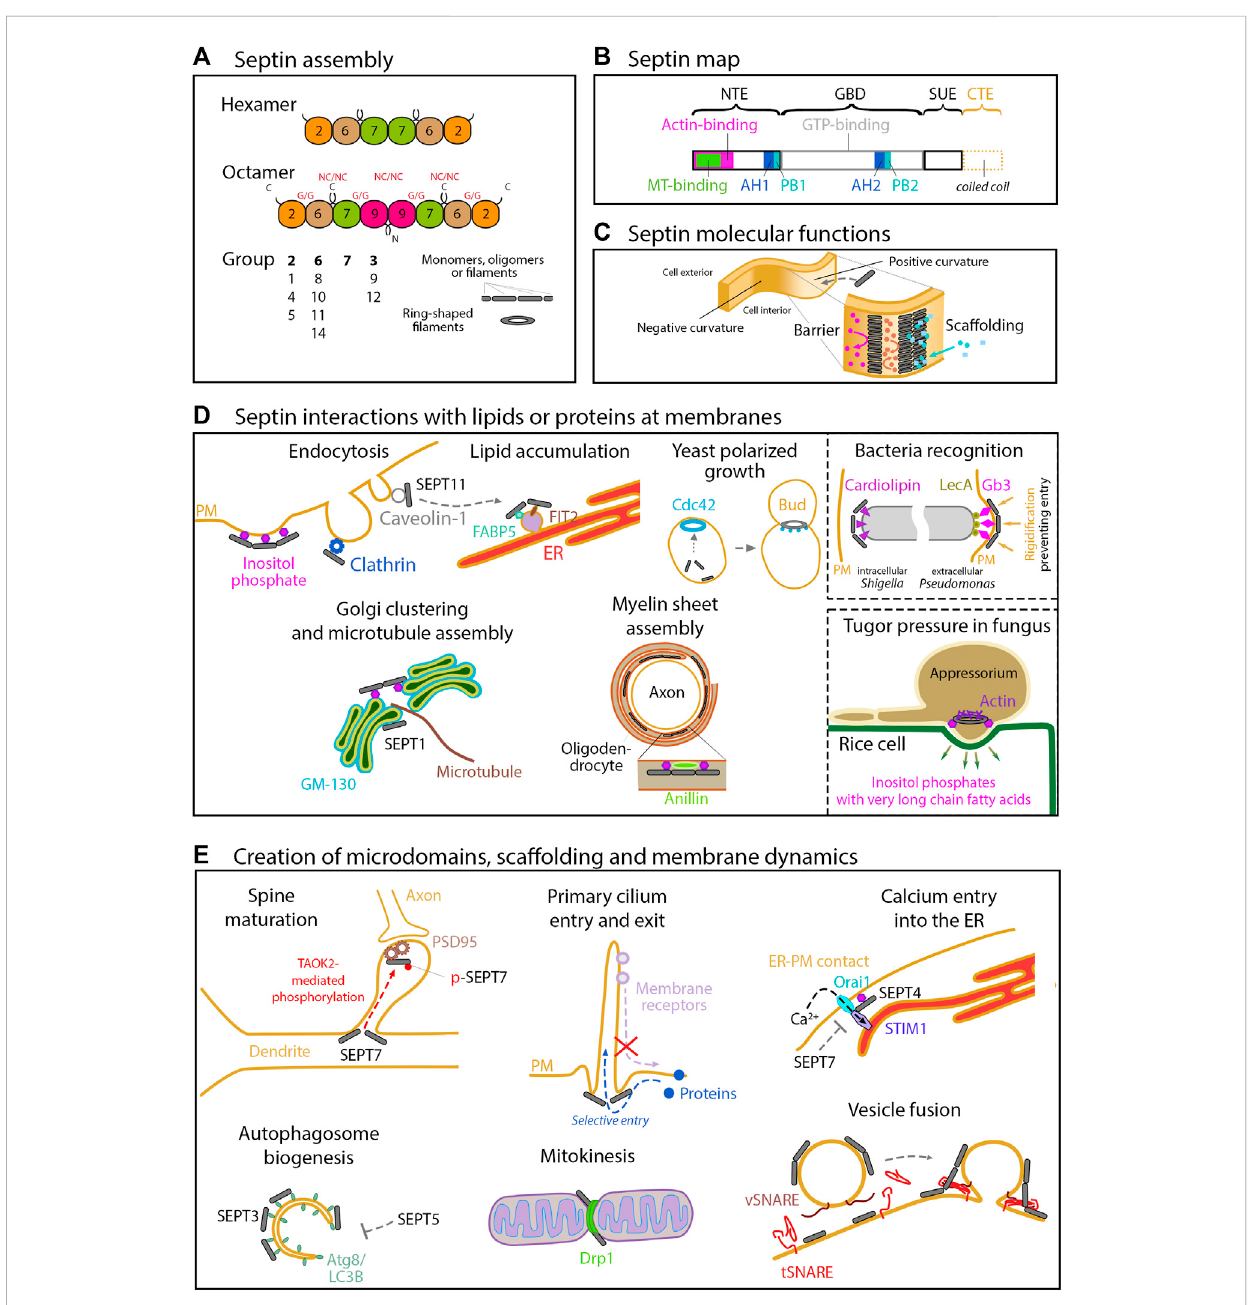
Septin structure, assembly and functions related to membranes. (A) Assembly of the septin cytoskeleton. In humans, the septin family comprises 13 members organized into 4 groups (2, 6, 7 and 3) according to their sequence homology. The organization of the four septin group into hexamers and octamers is depicted. Septin monomers either interact through their N- and C-terminal domains (NC/NC interfaces), or through their GTP-binding domain (G/G interfaces). These oligomers can then assemble into fi laments or into rings. (B) Structural domains encountered in septin proteins. All theseptinsexhibitaGTP-bindingdomain(GBD),aseptinuniqueelement(SUE),andN-andC-terminalextensions(NTE,CTE)ofvariablelength.Notethat the CTE, which contains one or more coiled-coil regions is absent in group 3 septins. Membrane binding is mediated by two AH (amphipathic helix) and PB (polybasic domain) motifs. SEPT9 exhibitsphysicalbinding to F-actin through the fi rst half ofits NTE, and to microtubulesthrough itsN-terminal K/R- R/x-x-D/Erepeatmotifs. (C) Septinmolecularfunctions.Atthemolecularlevel,septinscanformdiffusionbarriersoractasscaffolds,asillustratedherein thecontext ofbindingto apositivelycurved membrane.As abarrier,septins can either restrict entry orconcentratemolecules withinagiven domain. (D) Septins interact with lipids or proteins at membranes. Septins are enriched at positively curved membranes by binding to phosphoinositides. Through binding to other speci fi c lipids (cardiolipin, Gb3) in bacteria, and through binding to very long chain fatty acid-bearing phosphoinositides in M. orizae fungus, septins ultimately regulate pathogen invasion. In yeast, the membrane recruitment of septins follows high concentrations of active Cdc42, directing further outgrowth of the bud. Through binding to speci fi c proteins (Clathrin, Caveolin, FABP5, FSIT2, Anillin or GM130), septins are involved in a large array of cell processes in higher eukaryotes, including endocytosis, lipid storage, myelin sheet assembly, Golgi integrity and function in nucleating microtubules. (E) Septins canact as barriersor scaffoldsatmembranes.SEPT7 phosphorylationmediates PSD95 stability and restricts its mobilityto